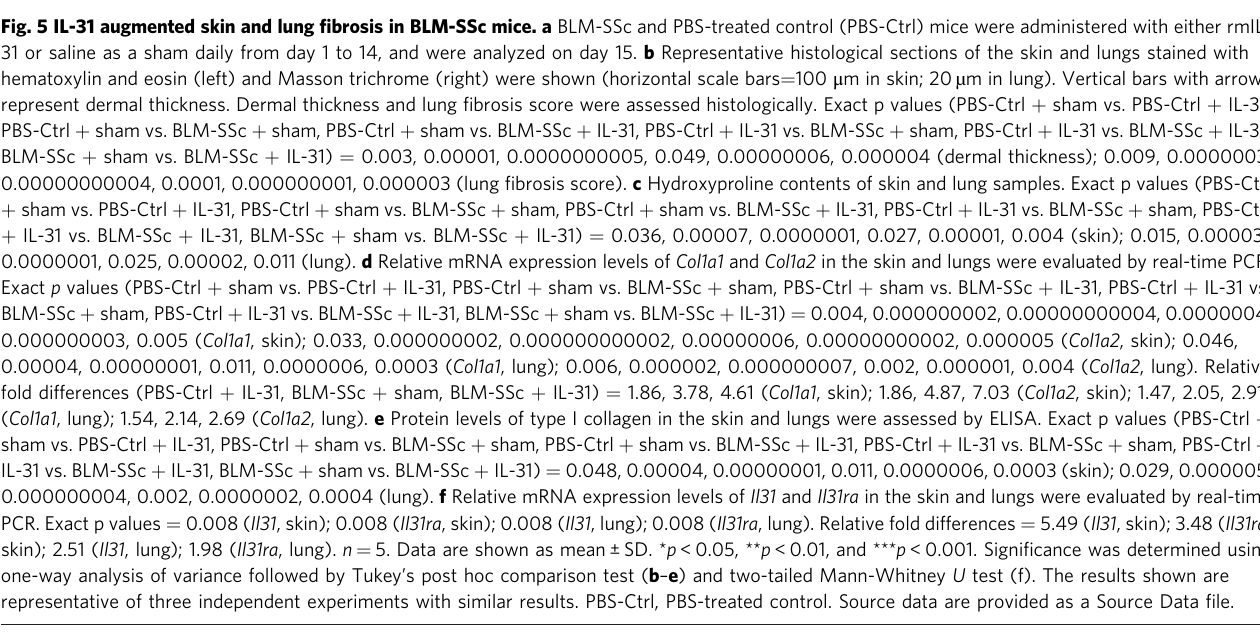
Fig. 5 IL-31 augmented skin and lung fi brosis in BLM-SSc mice. a BLM-SSc and PBS-treated control (PBS-Ctrl) mice were administered with either rmIL- 31 or saline as a sham daily from day 1 to 14, and were analyzed on day 15. b Representative histological sections of the skin and lungs stained with hematoxylin and eosin (left) and Masson trichrome (right) were shown (horizontal scale bars = 100 μ m in skin; 20 µ m in lung). Vertical bars with arrows represent dermal thickness. Dermal thickness and lung fi brosis score were assessed histologically. Exact p values (PBS-Ctrl + sham vs. PBS-Ctrl + IL-31, PBS-Ctrl + sham vs. BLM-SSc + sham, PBS-Ctrl + sham vs. BLM-SSc + IL-31, PBS-Ctrl + IL-31 vs. BLM-SSc + sham, PBS-Ctrl + IL-31 vs. BLM-SSc + IL-31, BLM-SSc + sham vs. BLM-SSc + IL-31) = 0.003, 0.00001, 0.0000000005, 0.049, 0.00000006, 0.000004 (dermal thickness); 0.009, 0.0000003, 0.00000000004, 0.0001, 0.000000001, 0.000003 (lung fi brosis score). c Hydroxyproline contents of skin and lung samples. Exact p values (PBS-Ctrl